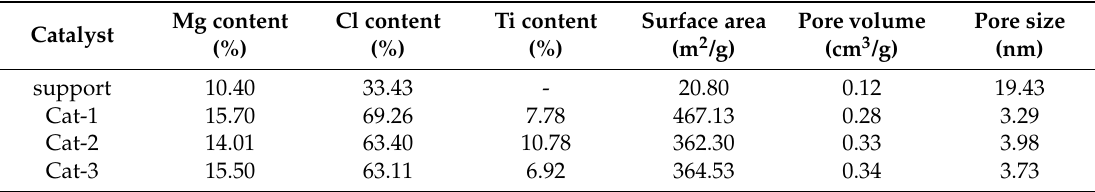
Table 1. Element content and pore structure parameters of the support and catalysts.